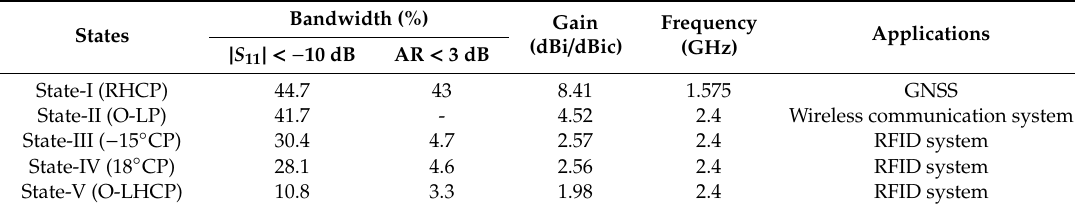
Table 4. Performance comparison of the di ff erent states of the reconfigurable